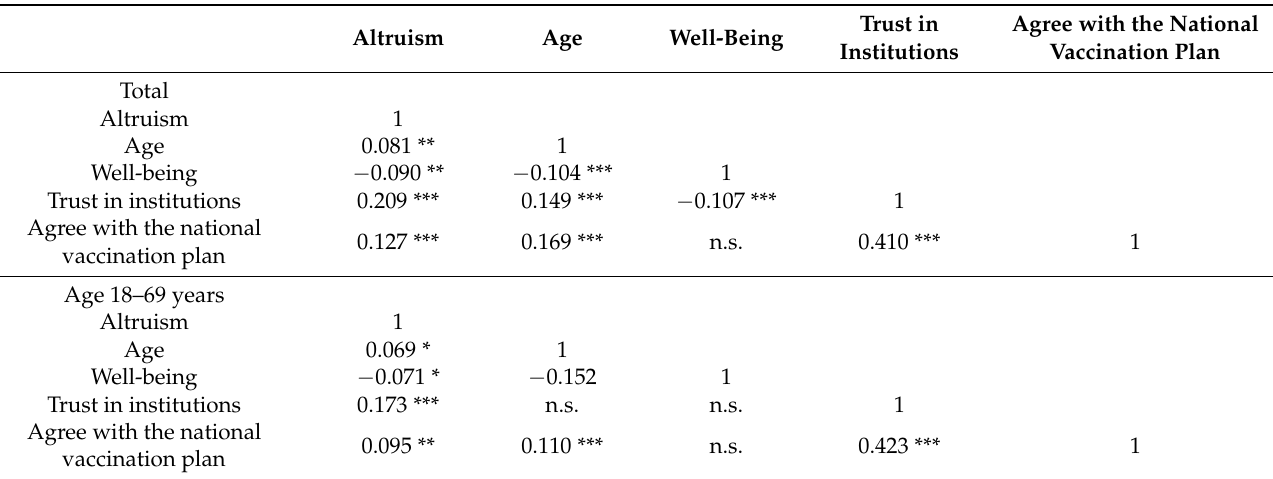
Table 1. Spearman‘s correlation coefficients between altruism, age, and well-being, and between altruism and conspiracy thinking, resilience, or trust in media.